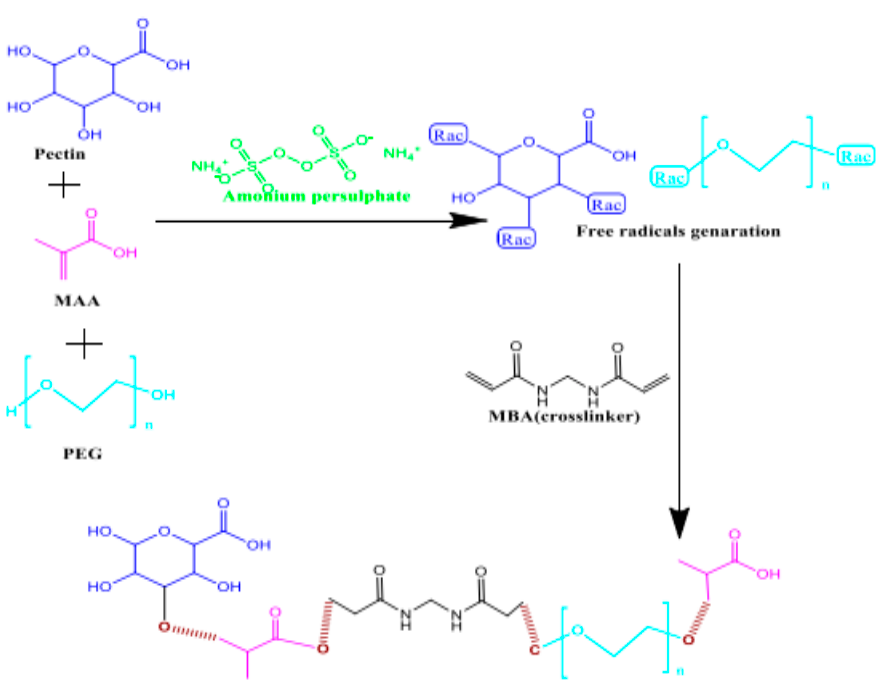
Figure 3. Scheme showing the formation of Pec-g-PEG-MAA hydrogels. Reproduced with permission [53].